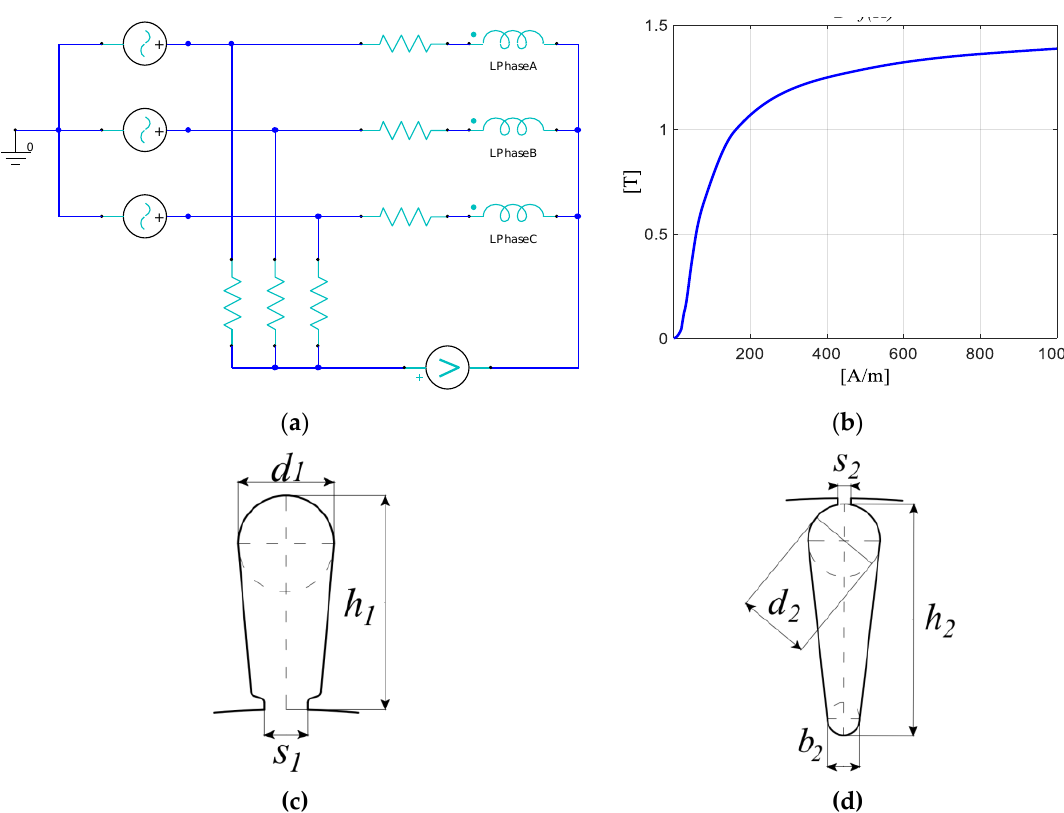
Figure 9. Electric circuit model in the FEM software, the B-H curve, the stator, and rotor slots’ dimensions: ( a ) stator winding connection to supply the voltage and measurement equipment in the Maxwell Circuit Editor ; ( b ) B-H curve of the M19 steel sheet; ( c ) stator slot, where: d 1 = 6.7 mm, s 1 = 3 mm, h 1 = 14.2 mm; ( d ) rotor slot, where d 2 = 5.3 mm, b 2 = 2.4 mm, s 2 = 1 mm, h 2 = 16.85 mm.